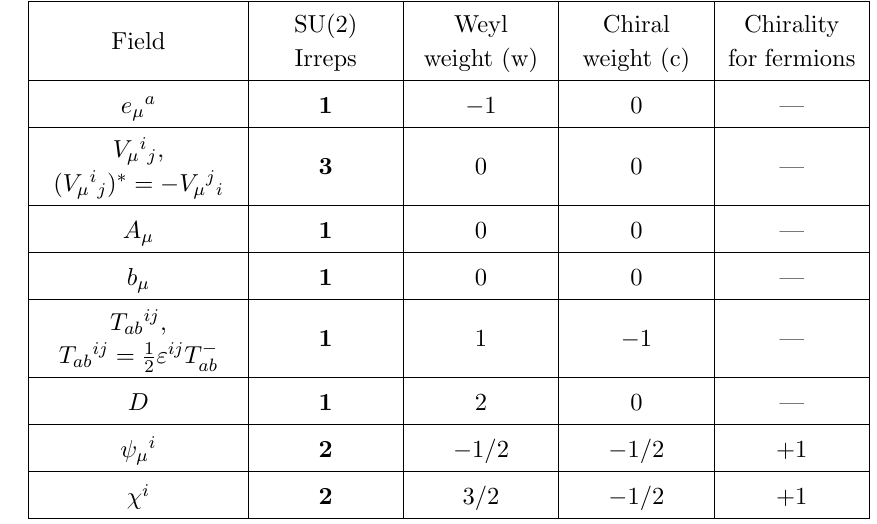
Table 1 . Weights and chiralities of standard Weyl multiplet